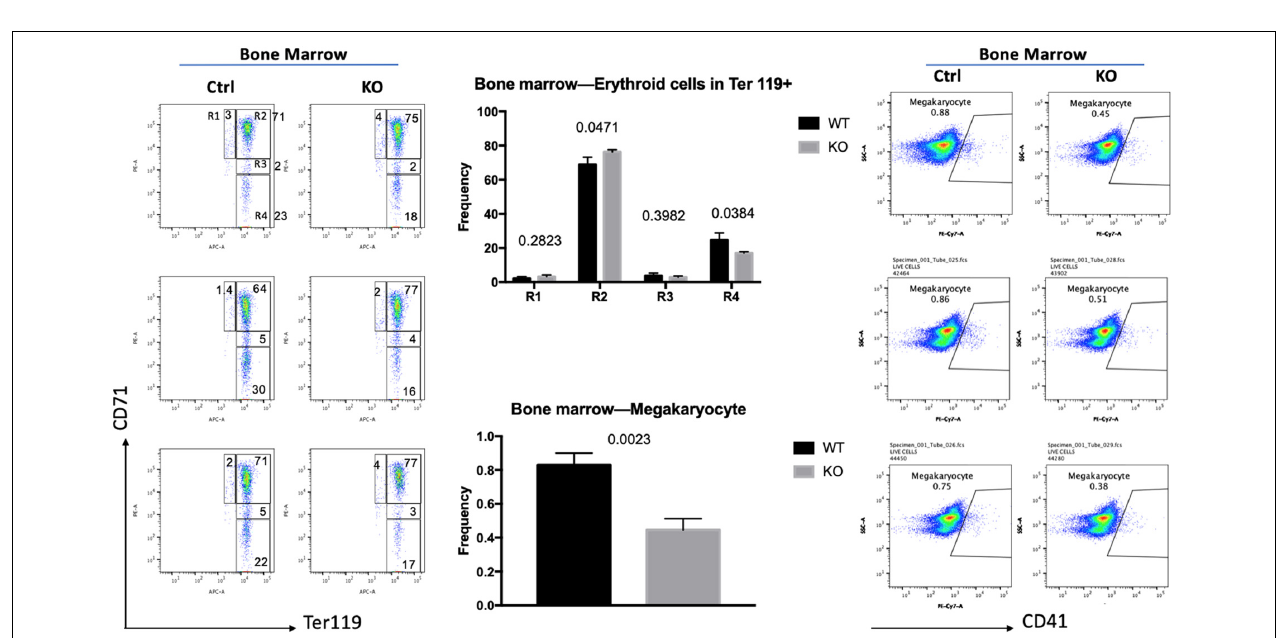
FIGURE 2 | Flow cytometry analysis of TFII-I KO and control bone marrow cells. BM cells isolated from three KO and three control mice (Ctrl) were subjected to flow cytometry analysis using CD71 and Ter119 antibodies (left) or CD41 antibodies (right). The numbers on top of the bars in the middle represent the p -values (error bars derived from three KO and three control mice, n = 3; p -values are shown on top of the graphs in the middle).